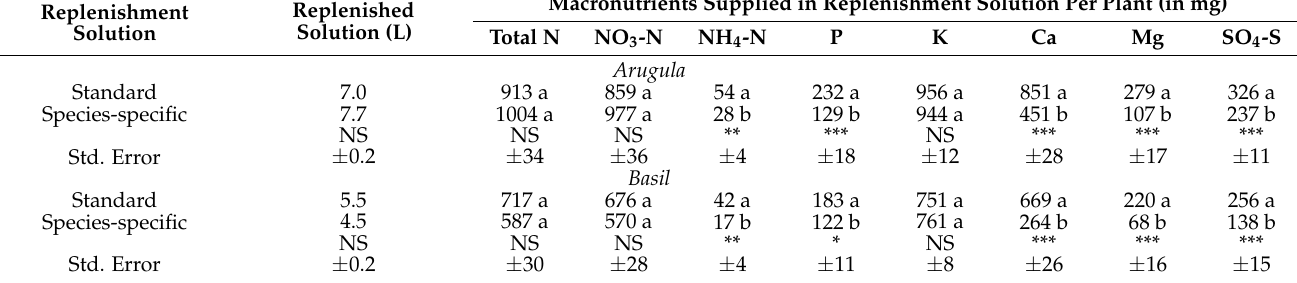
Table 3. Volume of solution replenished per plant and mass of total nitrogen (N), nitrate nitrogen (NO 3 -N), ammonium nitrogen (NH 4 -N), phosphorus (P), potassium (K), calcium (Ca), magnesium (Mg), and sulfate-sulfur (SO 4 -S) replenished per plant (in mg) from the replenishment solution at 21 d for arugula and